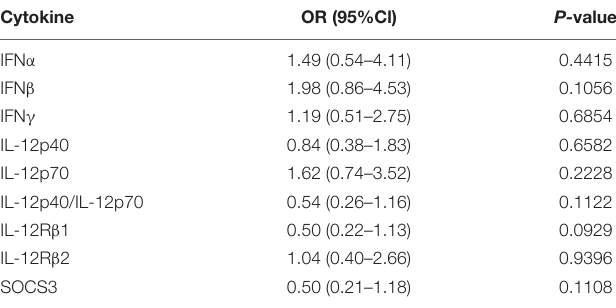
TABLE 4 | Effects of MedDiet on in vitro production of cytokines.